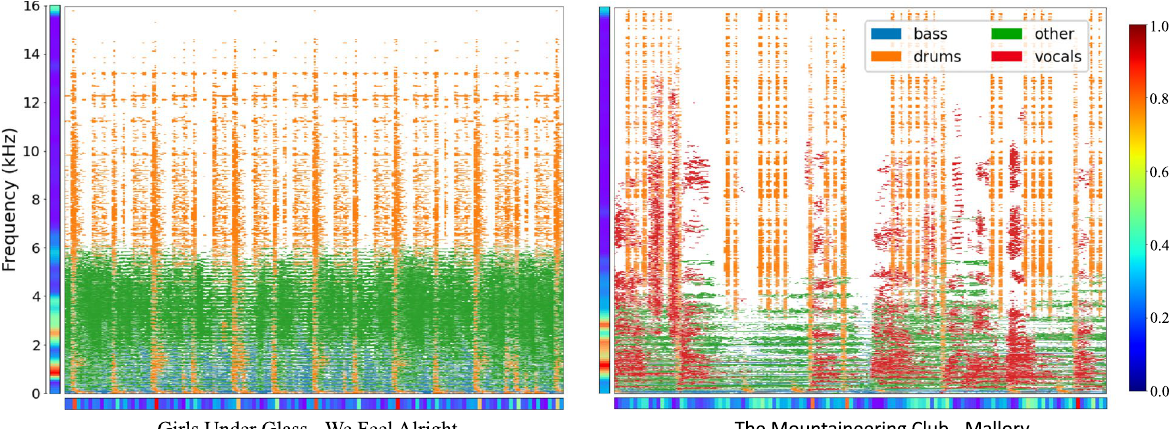
Fig. 6 Visualization of deep stripe feature learning results. Two song clips are taken from the Musdb18 test set. Magnitude spectrograms of the mixture are presented, in which four different colors represent the four constituent sources. On the left and bottom sides of each spectrogram, there are score bars which represent the average attention scores of horizontal and vertical stripes, respectively. The higher the score is, the greater attention the network pays to the